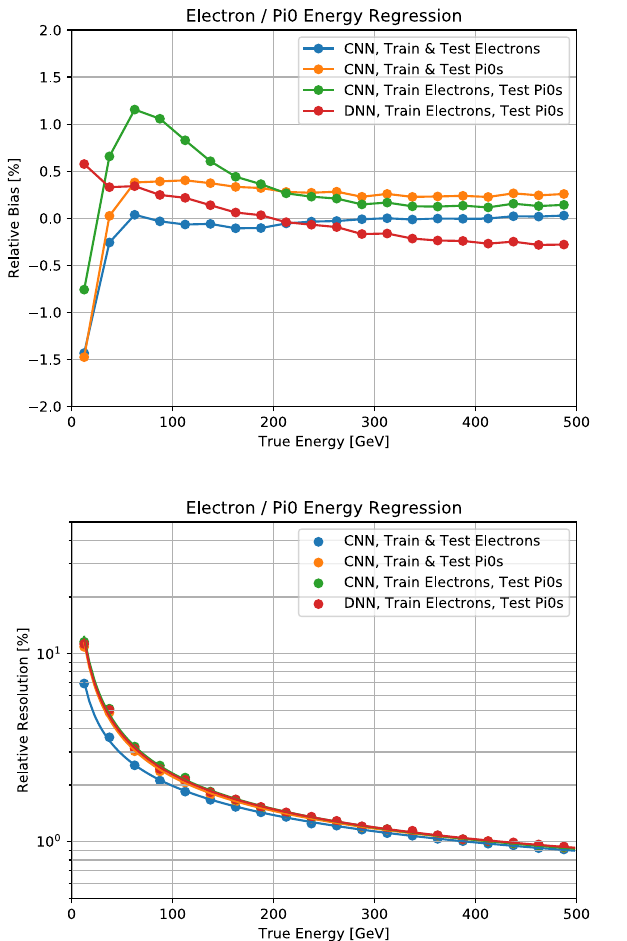
Fig. 37 Bias (top) and resolution (bottom) as a function of true energy, for electrons and π 0 . The particles used to train and test each algorithm are given in the legend